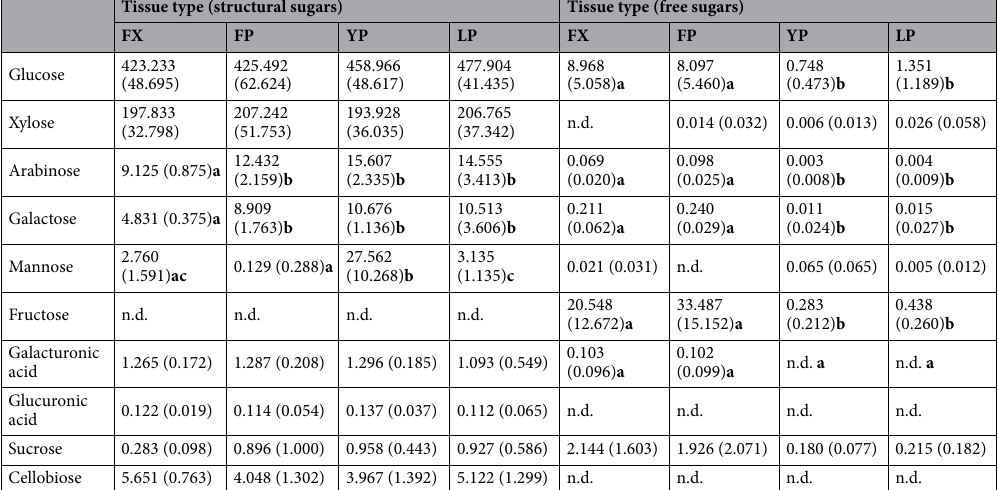
Table 2. Structural and free sugars of Pleioblastus simonii bamboo internodes. Each value represents the mean (SD) mg g −1 -sample of five internode samples. Different letters in bold indicate significant differences of a given sugar among tissue types by the Steel–Dwass test ( P < 0.05) after the Kruskal–Wallis test ( P < 0.05) in either structural or free sugars. No bold letters indicate no significant differences among tissue types by the Kruskal–Wallis test ( P > 0.05). Note that n.d. was regarded as 0 in statistical analyses. FX fresh xylem, FP fresh pith, YP pith on which Wickerhamomyces anomalus yeast had grown, LP pith on which W. anomalus and a larva of Doubledaya bucculenta had grown; n.d. not detected.